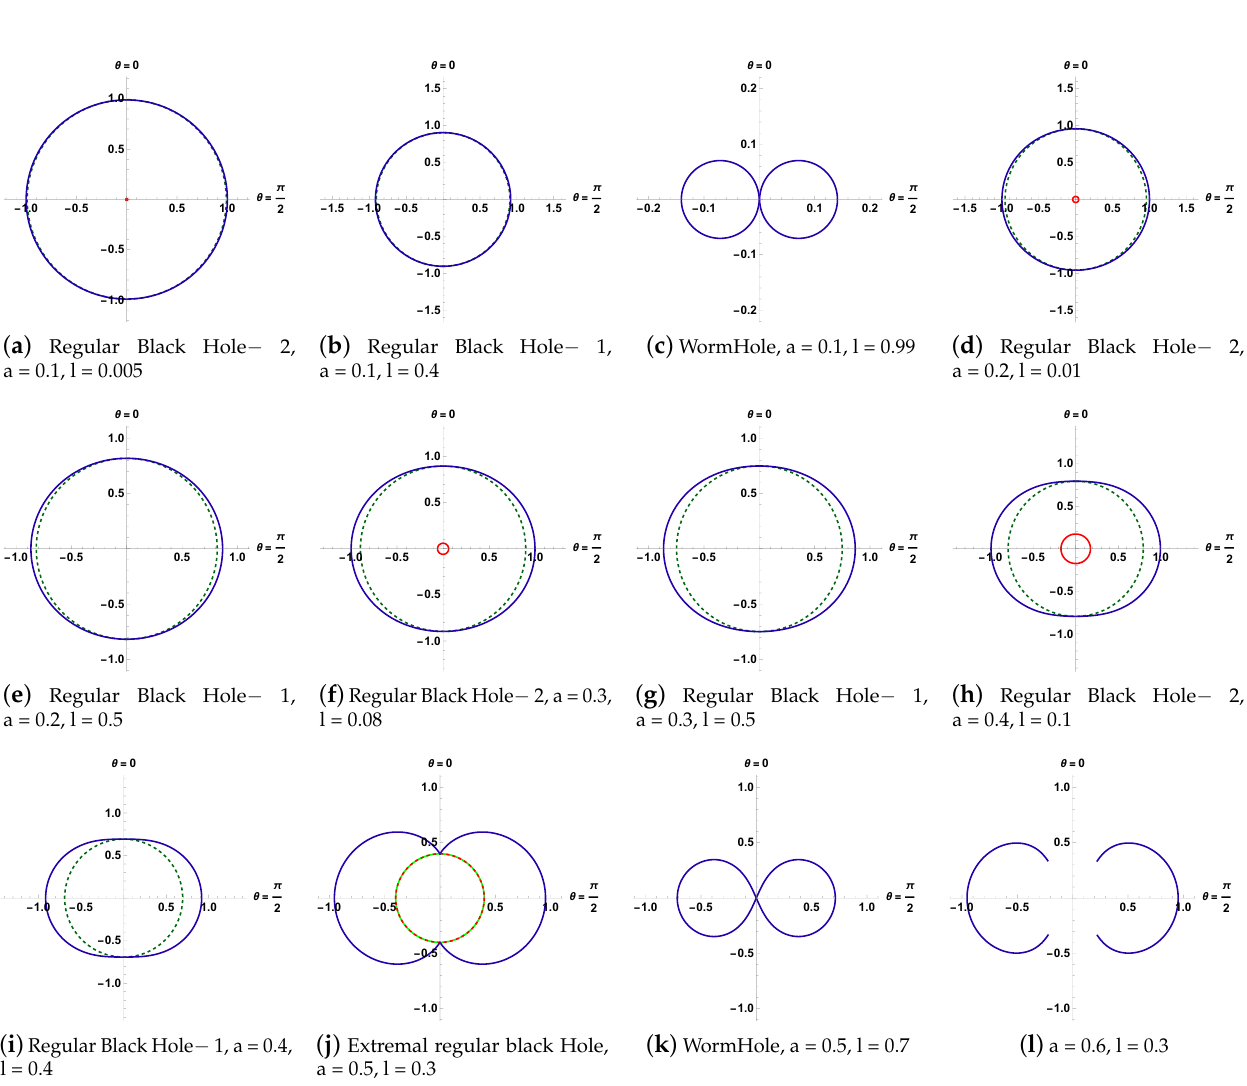
Figure 1. Figures show the behaviour of ergoregion and inner/outer horizon in rotating Simpson– Visser spacetime with different spin and regularisation parameters. The blue circle represents the boundary of the ergoregion, the green dotted circle represents the event horizon, and the red line represents the inner horizon; M =